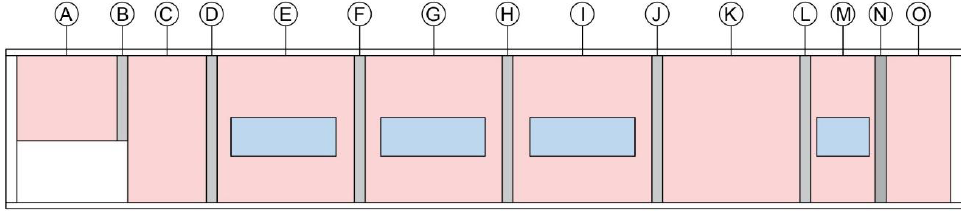
Figure 3. South wall surfaces identification within the CFD validated model.